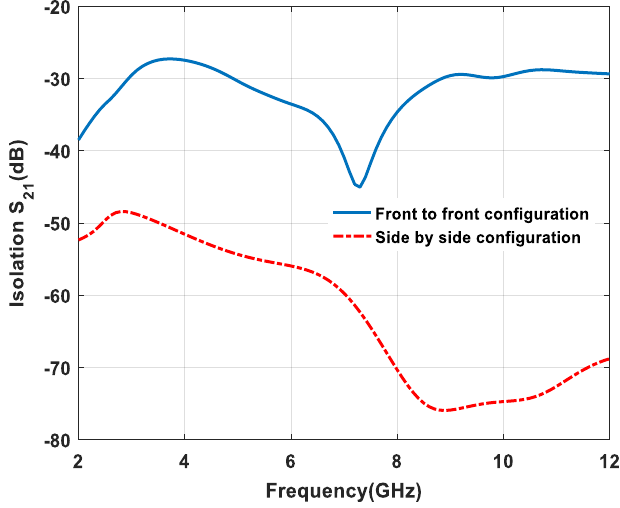
Figure 21. Isolation of S 21 versus frequency plot.